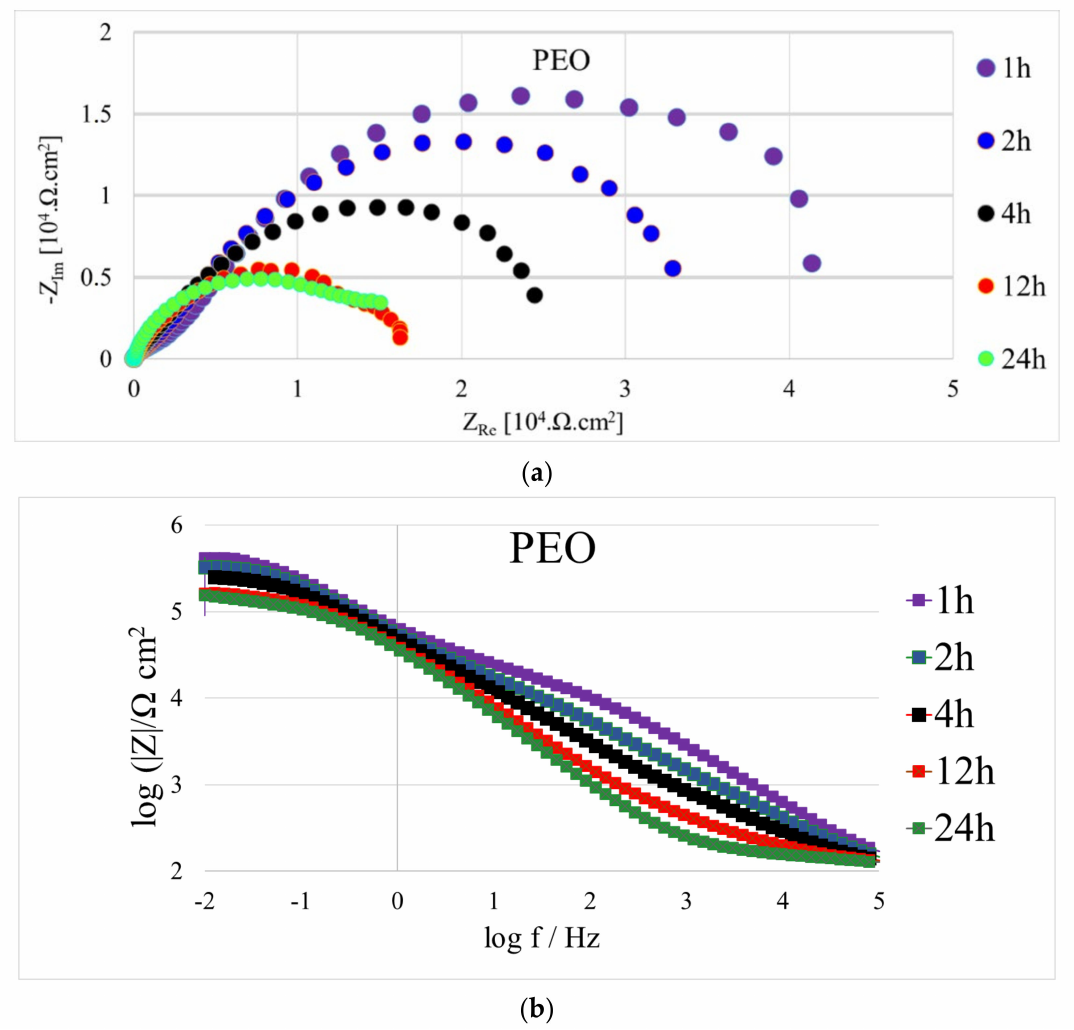
Figure 7. Electrochemical impedance behaviour of the PEO coated AZ91 after different exposure